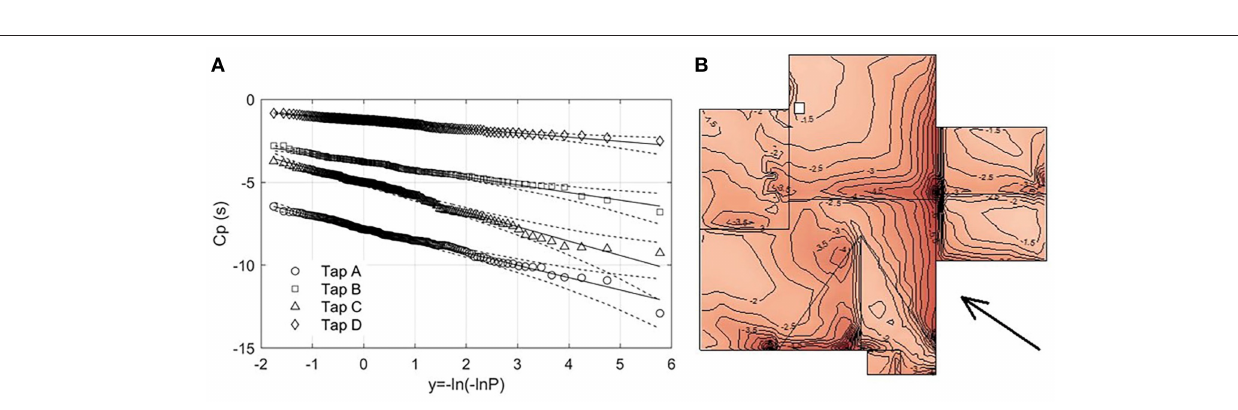
cases). However, the YGP method significantly